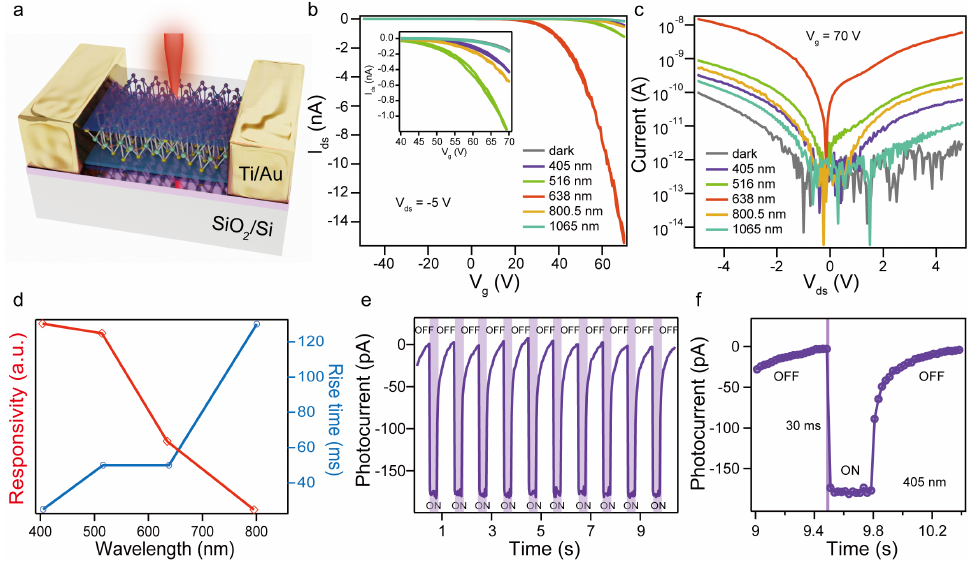
Figure 3. Photoelectric performances of the few-layered NiPS 3 photodetector at 77.3 K. ( a ) Demon- stration of the NiPS 3 phototransistor. ( b ) The transfer curves at − 5 V source-drain voltage in dark and under illumination. ( c ) Current-voltage curves at 70 V gate voltages in the dark and under illumina- tion. ( d ) Photoresponsivity (red) and rise time (blue) as a function of wavelength at V ds = − 5 V and V g = 70 V. ( e ) Photoswitching behavior under illumination with a wavelength of 405 nm. V ds = − 5 V and V g = 70 V. ( f ) Photoresponse time of the NiPS 3 detector, and rise time is 30